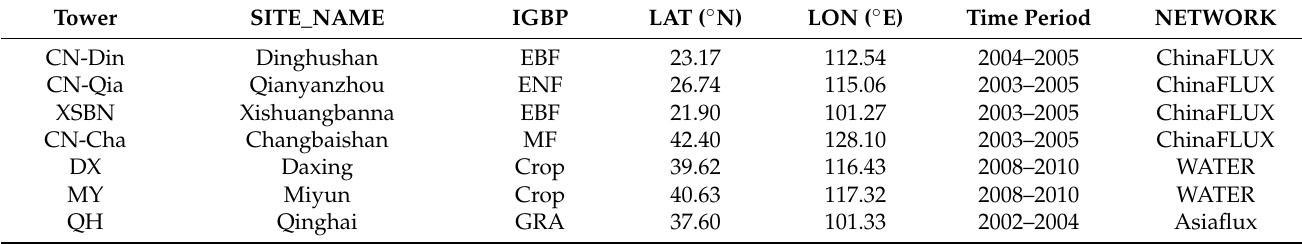
Figure 1. ( A ) Locations of the study area, 17 eddy covariance sites and 577 meteorological stations. ( B ) Land cover classification and ( C ) soil classification from the International Geosphere–Biosphere Programme (IGBP) used in this study. Table 1. Description of 17 eddy covariance sites used in this study.